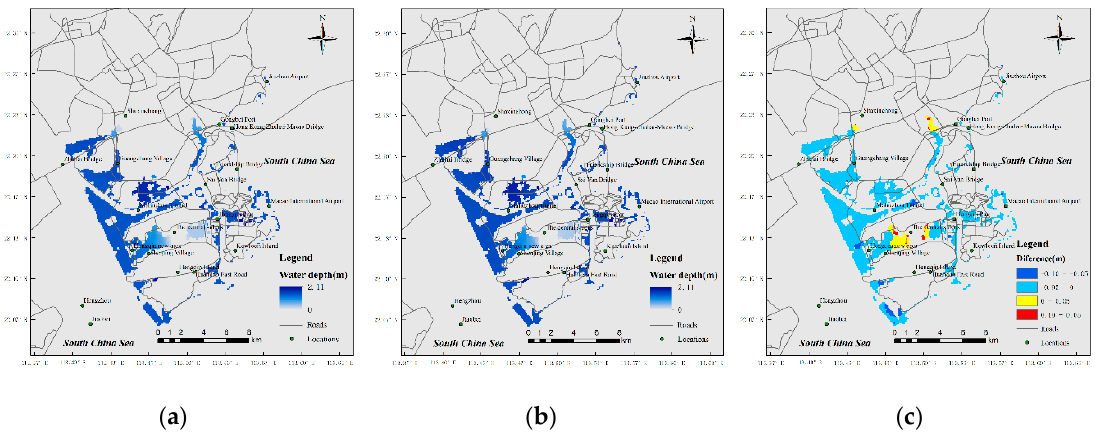
Figure 7. Inundation estimated by ( a ) MIKE 21 and ( b ) the CA simulated inundation, and ( c ) their difference (MIKE 21-CA) at 120 min.